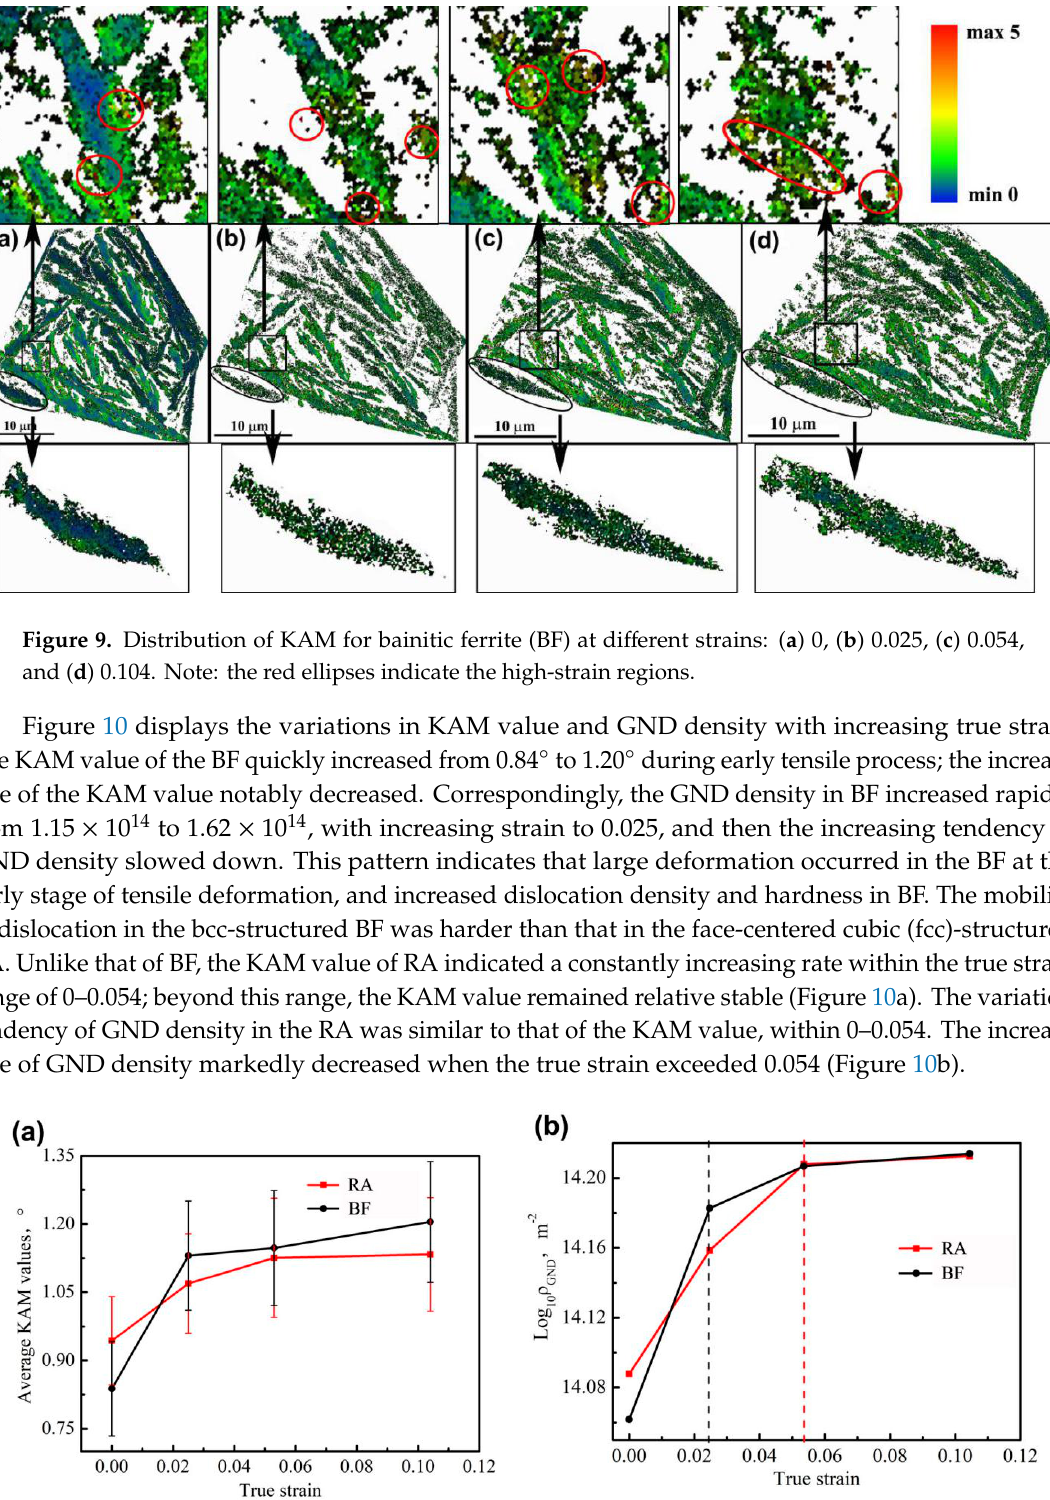
Figure 10. Variations of the KAM value ( a ) and logarithm of the geometrically necessary dislocations (log-GNDs) ( b ) in RA and BF, with true strains.